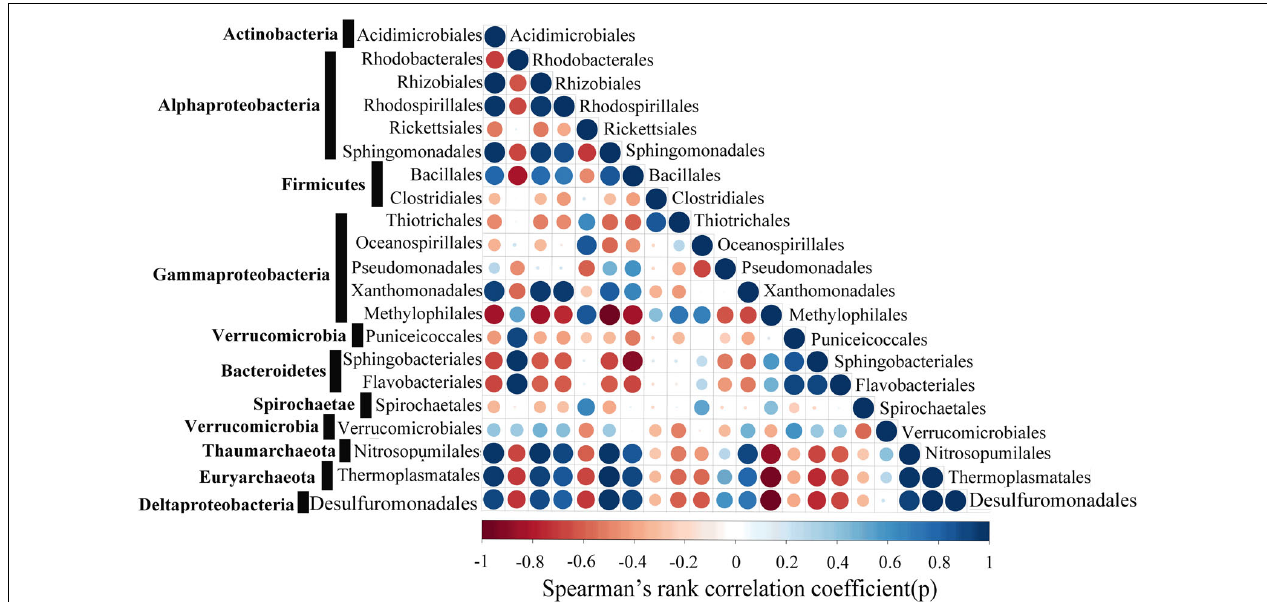
FIGURE 9 | Network co-occurrence patterns with Spearman’s P- value < 0.01. Each dot represents a significant correlation between two microbial taxa with red and blue representing negative and positive correlations, respectively.